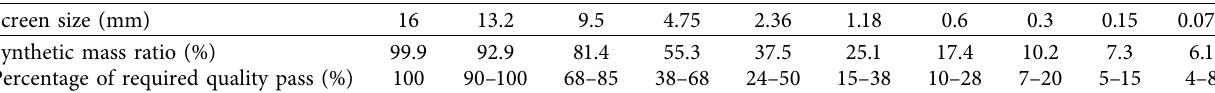
Table 5: Mineral grade grading of the AC-13 asphalt